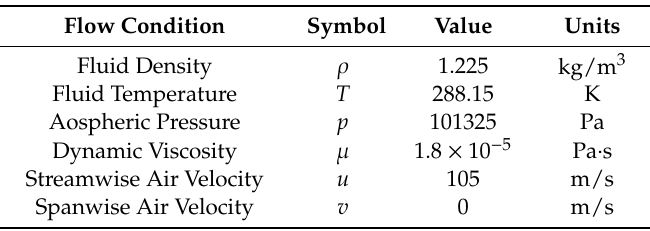
Table 4. Summary of fluid and flow conditions.